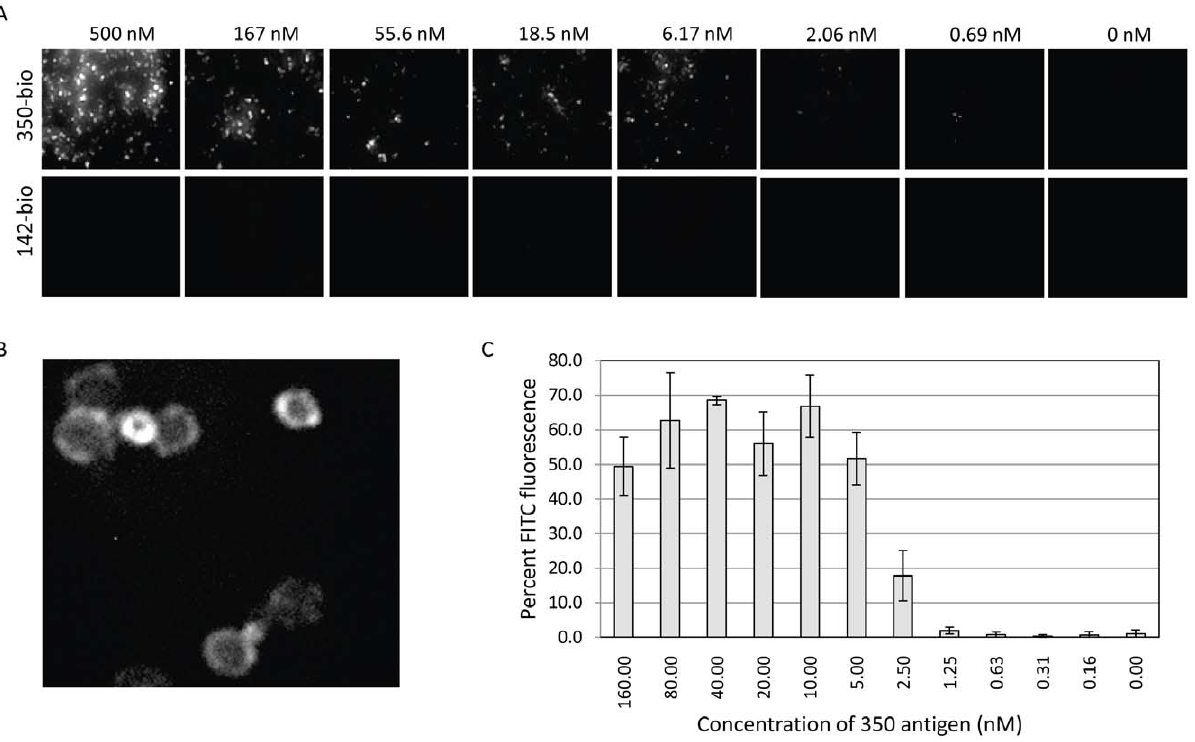
Figure 4. Immunofluorescence assay using lyophilized yeast-scFv reagents. Panel A shows lyophilized, reconstituted 350-E2 yeast binding to cognate 350 antigen (upper row) or non-cognate 142 (lower row) in concentrations ranging from 500 nM down to 0.69 nM in threefold serial dilutions. Bound antigen was detected by incubating with a rabbit anti-350 antiserum followed by GaR-FITC detection. Stained yeast were viewed at 40 6 magnification. Panel B is the 500 nM concentration of 350-biotin binding seen in Panel A, but photographed at 90 6 magnification and digitally zoomed 3 6 to visualize staining patterns. Panel C shows a graph of a second experiment in which 350-biotin was tested in triplicate using 11 concentrations ranging from 160 nM down to 0.14 nM in twofold serial dilutions. For each concentration, 3 fields were photographed twice, first in visible mode, and then in FITC mode. The percent of FITC-positive yeast were calculated and graphed relative to the concentration of 350 antigen.